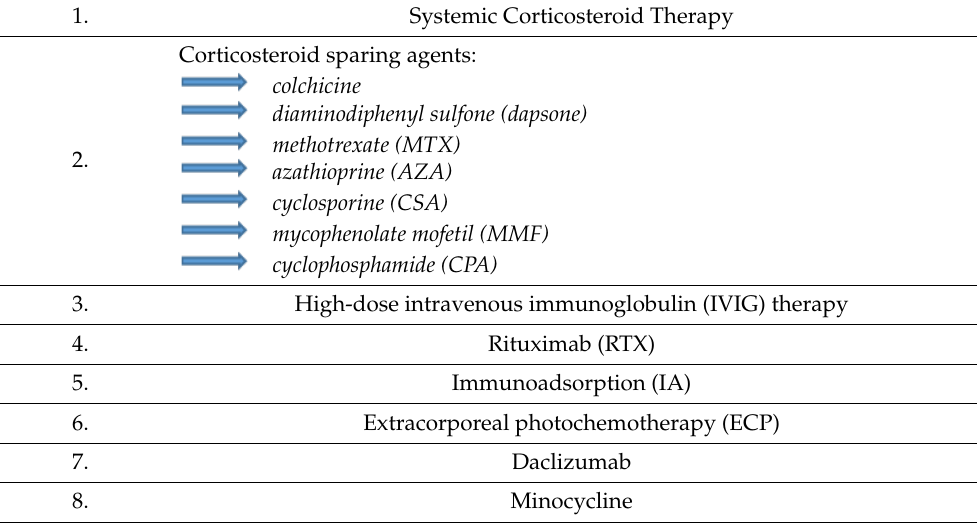
Table 1. EBA’s current treatment options.